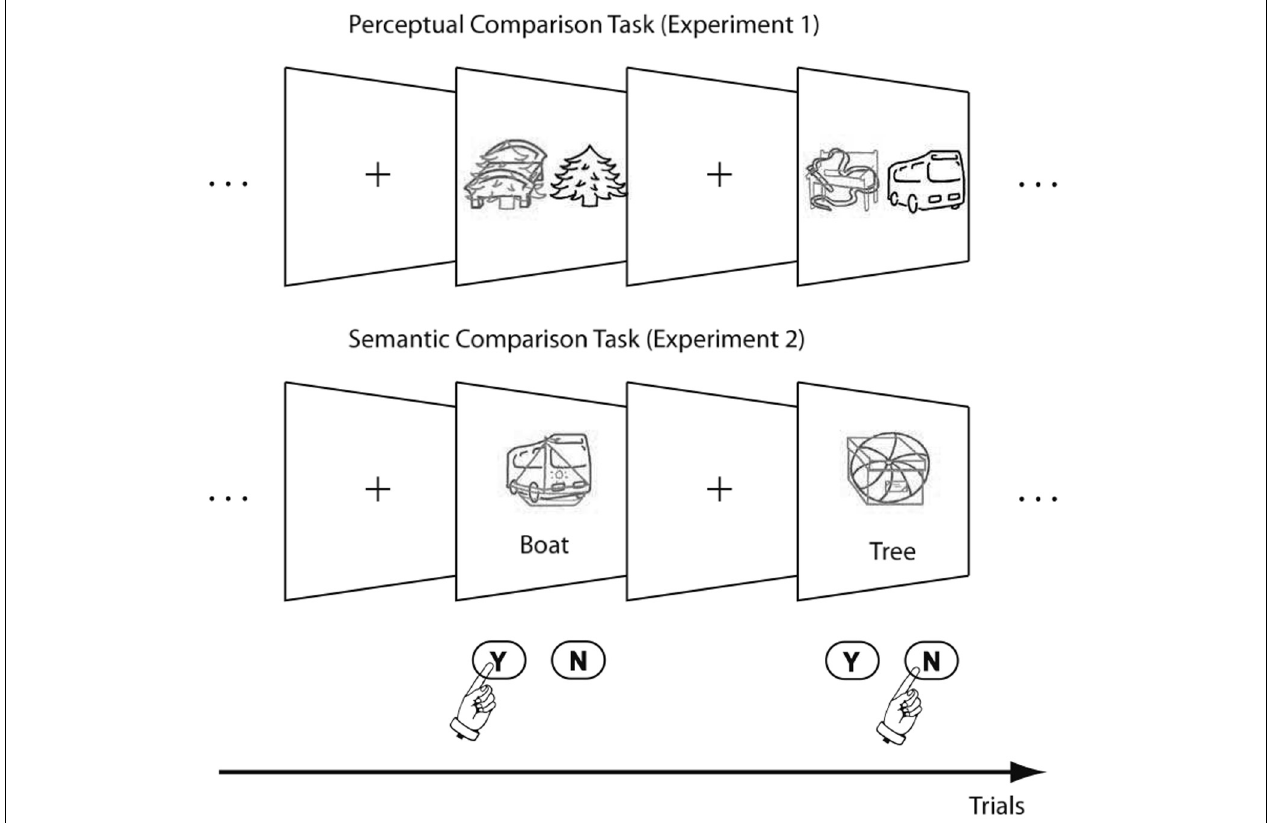
FIGURE 1 | Example Stimuli for the two experiments. The green (light-gray) target had to be compared to the gray (black) reference object or word.